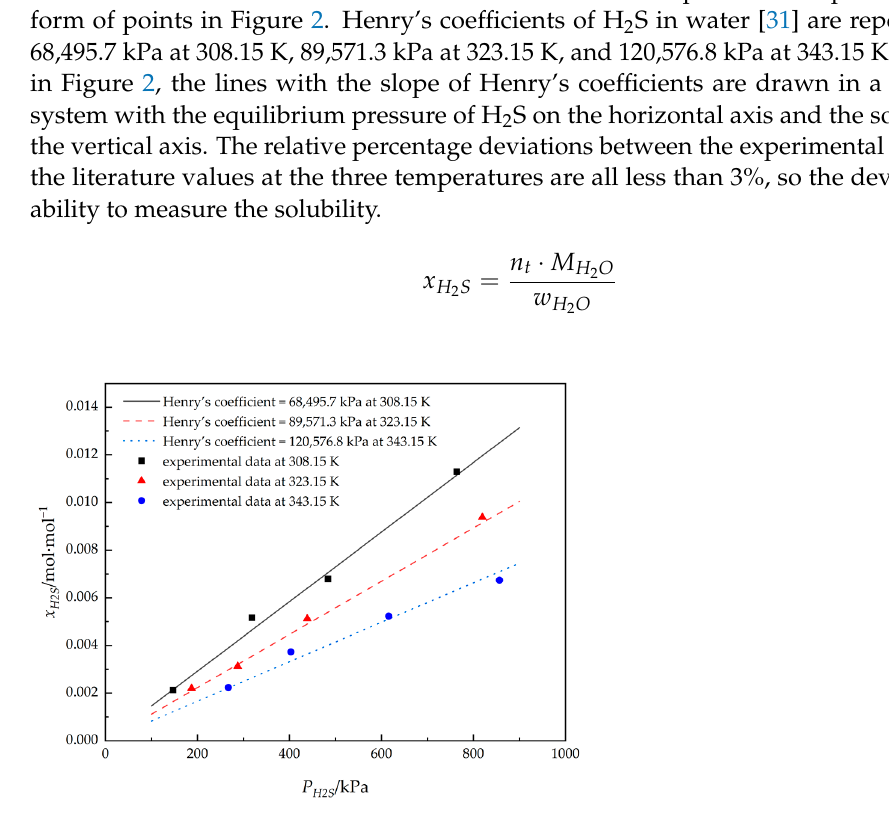
Figure 2. Comparison of experimental values and literature values of H 2 S solubility in water.